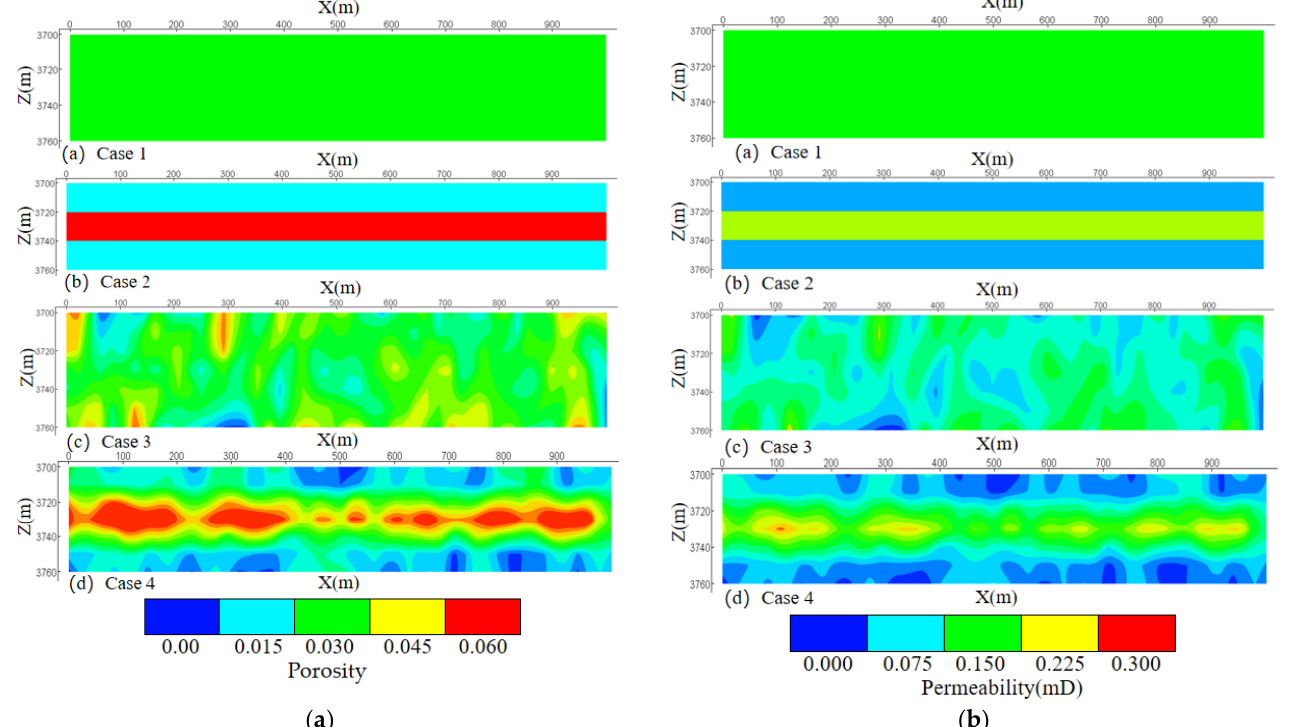
Figure 4. ( a ) Comparison of permeability distribution of caprock in four schemes; ( b ) comparison of permeability distribution of caprock in four schemes.